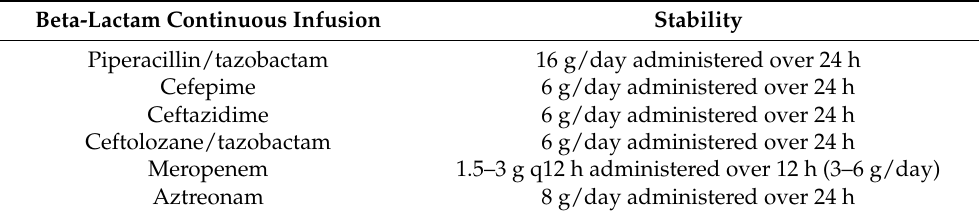
Table 3. Established stability of continuous infusion beta-lactams